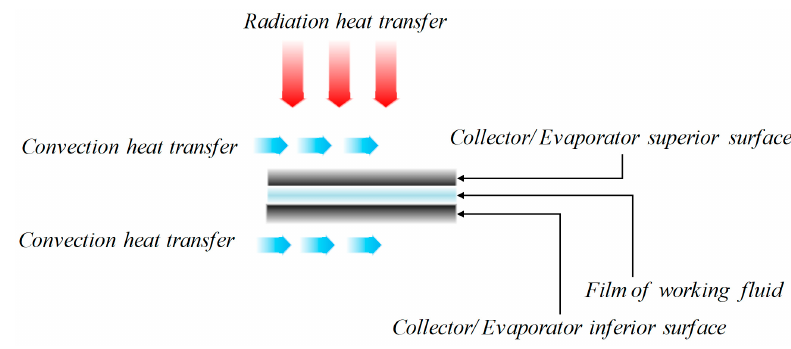
Figure 3. Cross-section of the solar collector/evaporator.